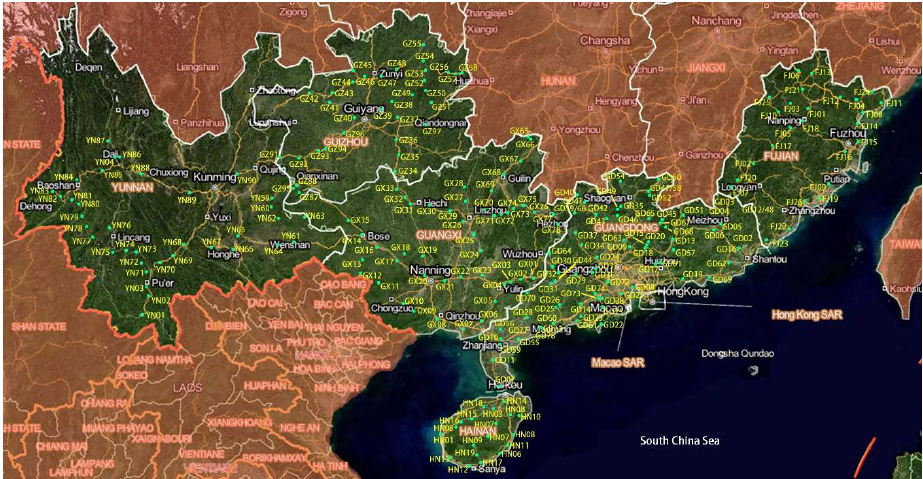
Figure 1. The map of sites distribution for the soil samples collection. 77